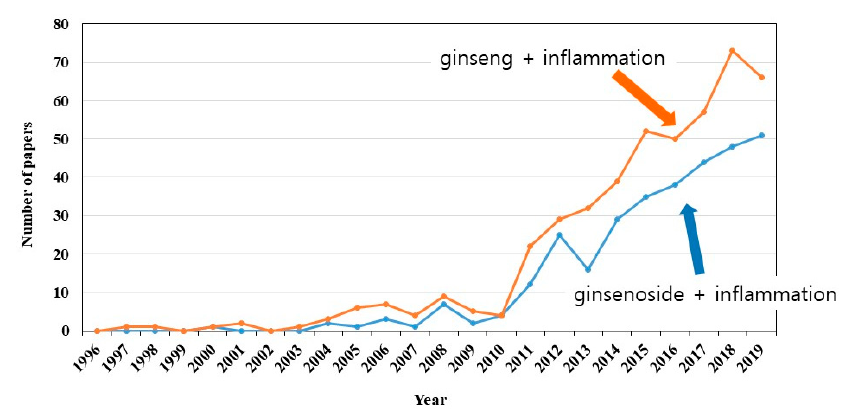
Figure1. Annualchangesinthenumberofpublishedpapersonginseng, ginsenoside, Figure 1. Annual changes in the number of published papers on ginseng, ginsenoside, and inflammation.